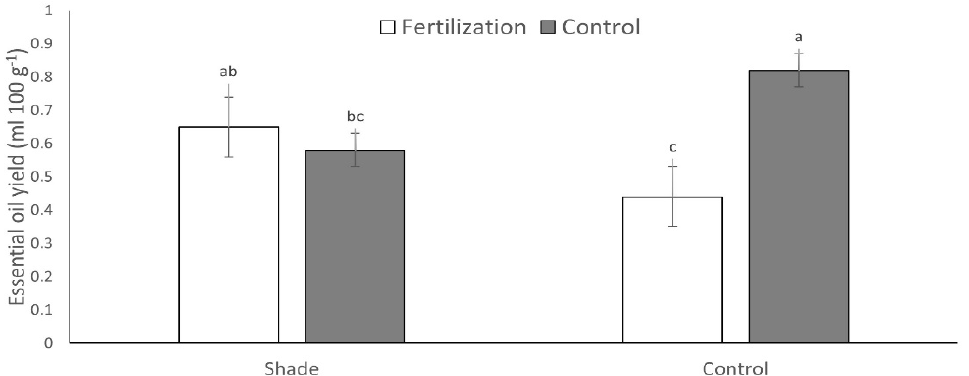
Figure 1. Effects of shading and fertilizer application on the essential oil yield of chamomile. Columns followed by the same letter are not significantly different ( p ≤ 0.05).